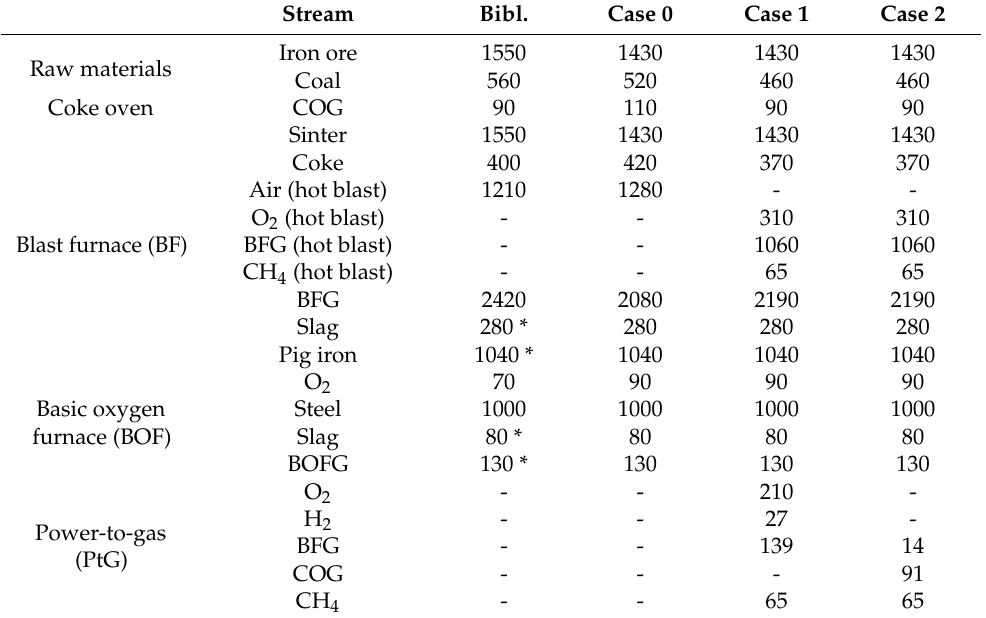
Table 2. Mass flows (kg/t steel) of the main streams calculated for Case 0, Case 1, and Case 2.